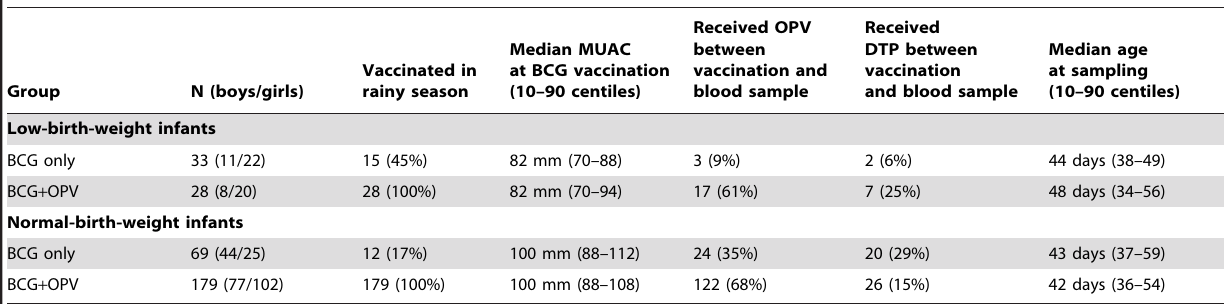
Table 1. Description of the cytokine study population.